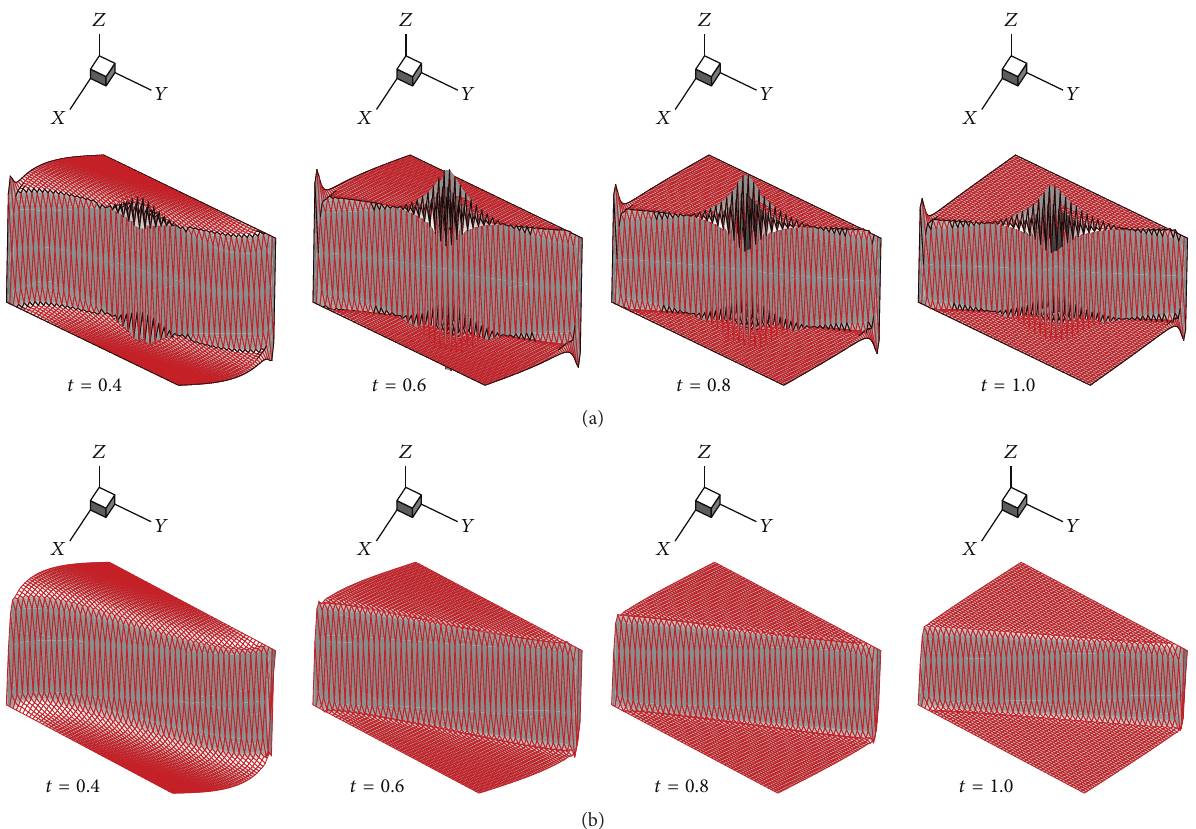
Figure 11: 2D Burgers’ equation for Re = 10 4 . (a) are computed without filter; (b) are with the low-pass filter.